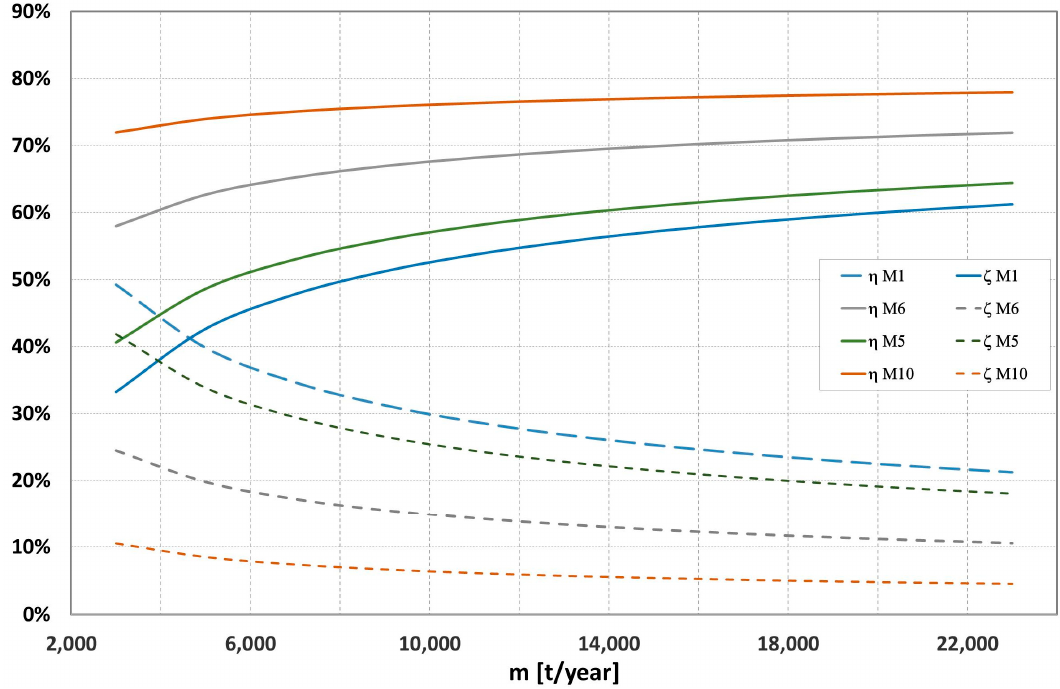
Figure 6. Efficiency and Inefficiency with changes in yearly flow rate and substrate typology.